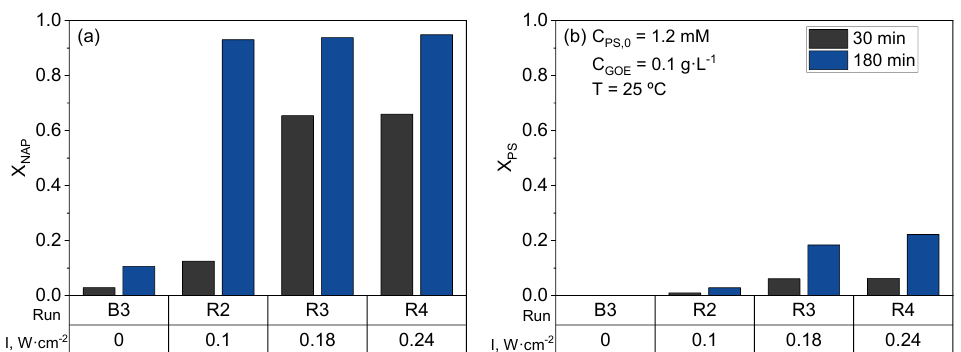
Figure 1. Effect of irradiance in ( a ) conversion of NAP; ( b ) conversion of PS at 30 min and 180 min. C NAP,0 = 0.1 mM, C PS,0 = 1.2 mM, C GOE = 0.1 g · L − 1 and 25 ◦ C.